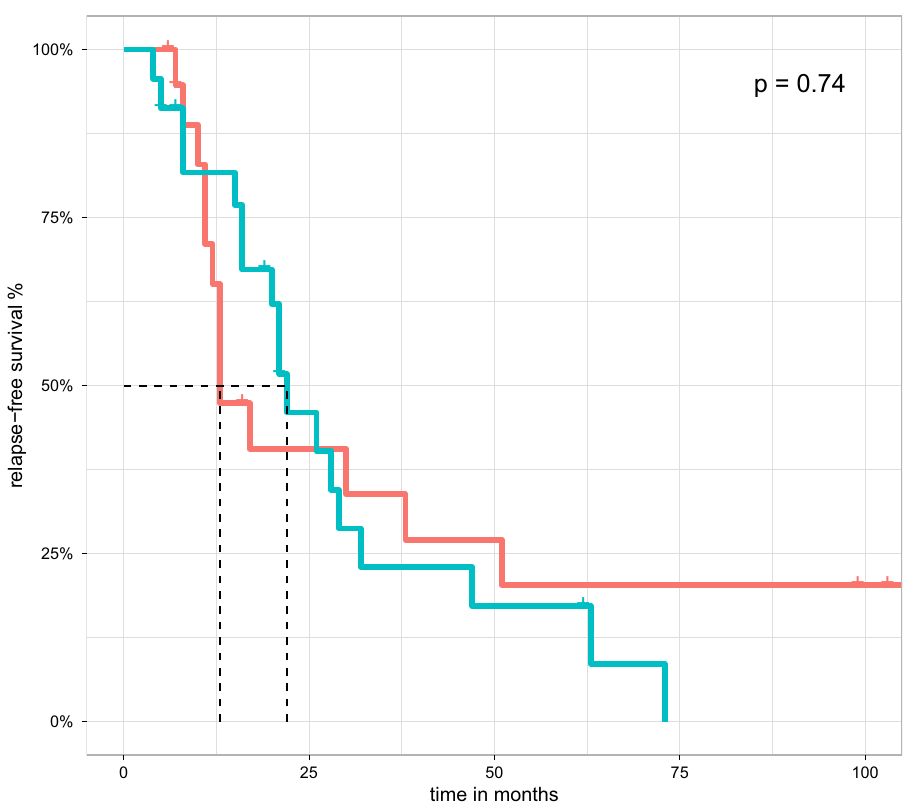
Figure 4. Kaplan-Meier estimate showing the relapse-free survival of MCD/FSGS patients treated with RTX stratified by age at first induction with RTX. Patients with first induction at the age ≥ 31 years did not show any significant difference from patients who were diagnosed before the age of